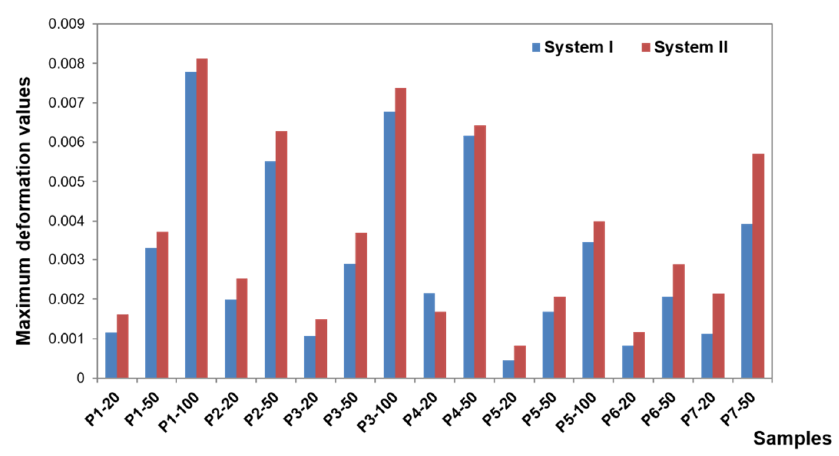
Figure 15. Maximum matrix deformations for systems I and II.